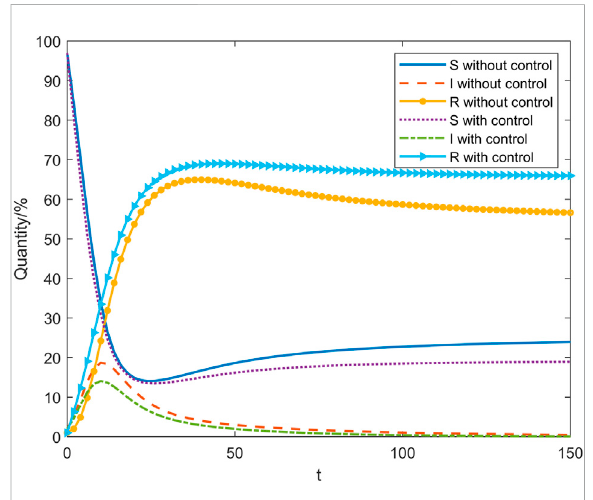
FIGURE 12 Comparison of the changes in the number of nodes without and with control of the